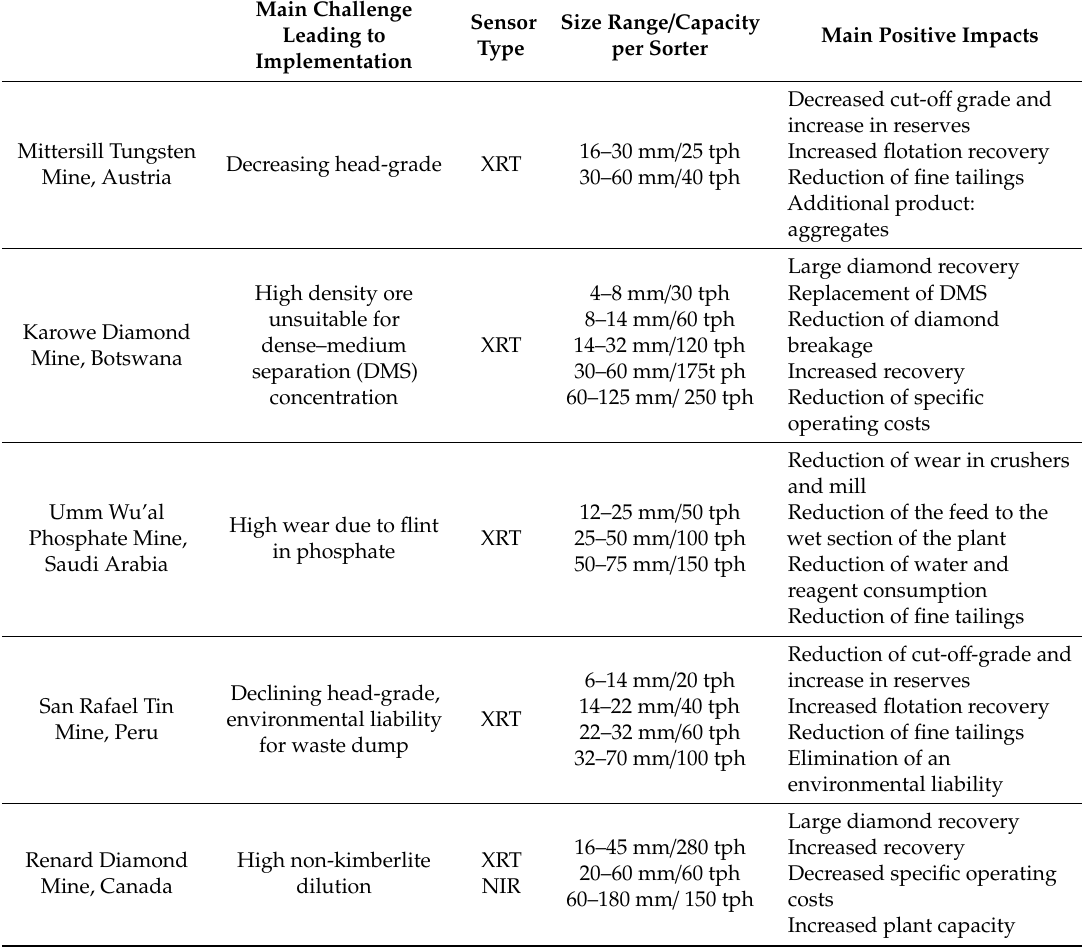
Table 4. Summary of lighthouse